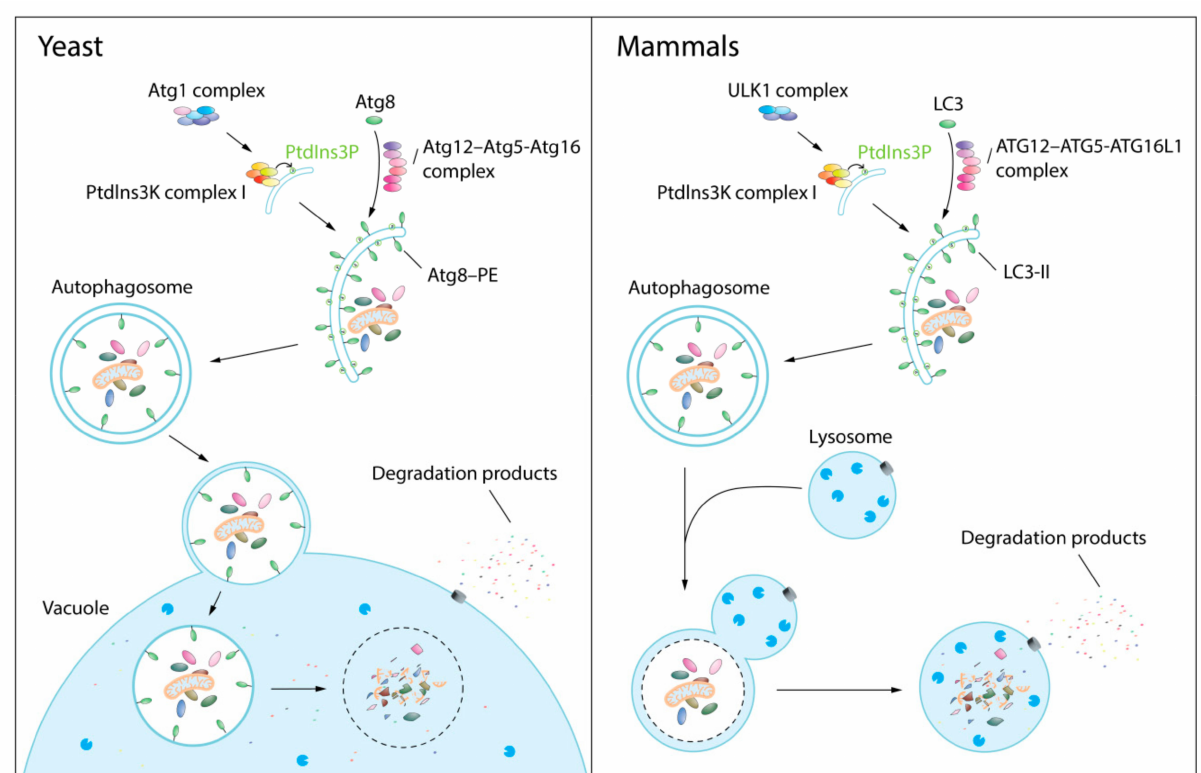
Figure 1. The autophagy process in yeast and mammalian cells. When autophagy is induced, the activated Atg1/ULK1 (yeast/mammals) complex activates downstream effector proteins, in- cluding Atg14/ATG14. The activated Atg14/ATG14-containing class III phosphatidylinositol (Pt- dIns) 3-kinase (PtdIns3K) complex I then produces phosphatidylinositol-3-phosphate (PtdIns3P) at the phagophore assembly site to promote vesicle nucleation. With the help of the Atg12–Atg5- Atg16/ATG12–ATG5-ATG16L1 complex, Atg8/LC3 is conjugated to phosphatidylethanolamine (PE) at the phagophore membrane to generate Atg8–PE/LC3-II. The phagophore expands and engulfs cytoplasmic cargoes, forming a mature autophagosome. The autophagosome is then fused with the vacuole in yeast cells or a lysosome in mammalian cells, where the cargoes are degraded by acid hydrolases. The degradation products, such as amino acids, are released back to the cytosol by permeases in the vacuolar or lysosomal